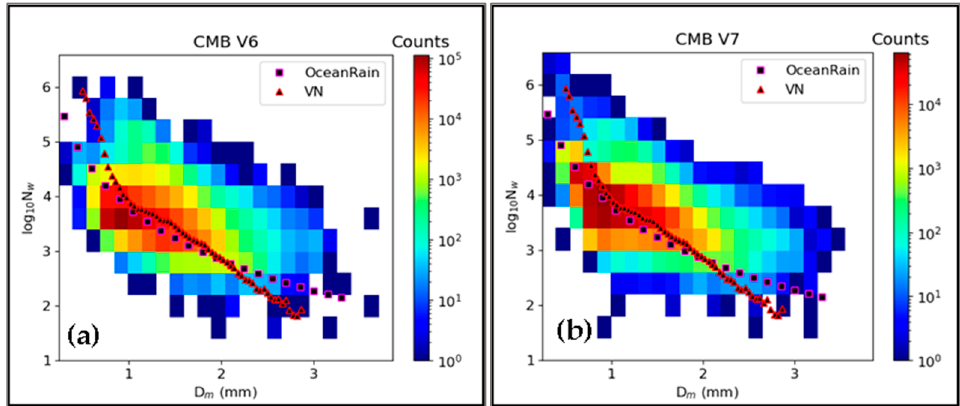
Figure 14. Two-dimensional histogram (or density plot) of joint (N w , D m ) variables derived using version 6 (V6; panel a ) and version 7 (V7; panel b ) of the combined algorithm. Superimposed are the mean N W –D m derived from the Validation Network (VN) and used to constrain the retrievals in V6 and V7 (symbolized with triangles) and the fit to OceanRain N W –D m data (symbolized with squares).